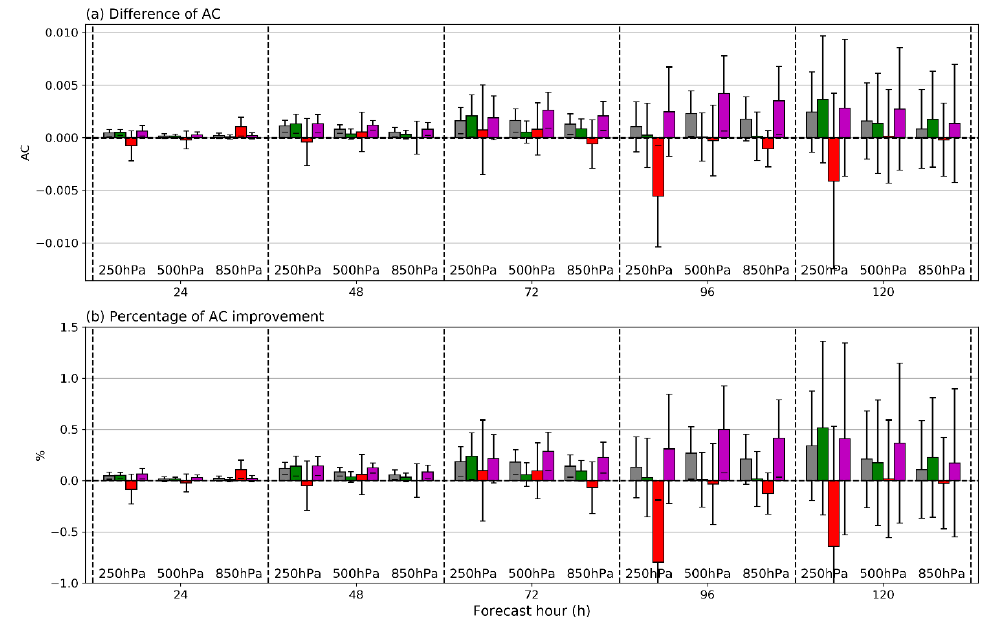
Figure 10. The ( a ) mean and ( b ) normalized difference of AC of 250 hPa, 500 hPa, and 850 hPa temperature forecast up to 120-h forecast hours between the latency_20m and control runs. Grey, green, red, and magenta boxes indicate the results over the Global, Northern Hemisphere, Tropic, and Southern Hemispheres, respectively. Vertical bars representing 95% confidence level of the uncertainty are overlaid.